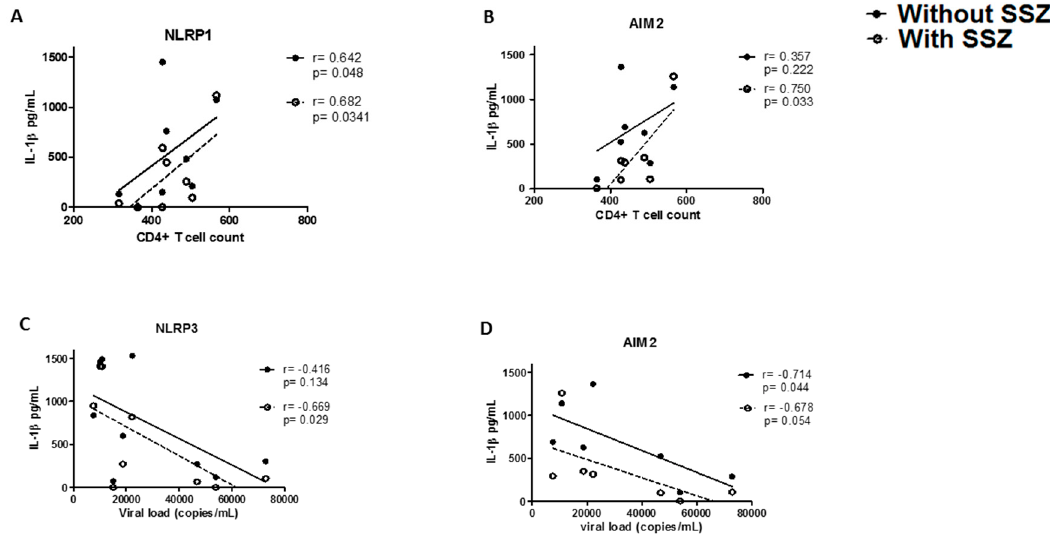
Figure 5. Correlation between IL-1 β release in response to inflammasome agonists and sulfasalazine (SSZ) in term of the CD4+ T cells count or viral load. The effect of SSZ on IL-1 β release through inflammasomes was determined in people living with HIV, on the basis of the CD4 + T cell count ( A , B ) and viral load ( C , D ). The correlations were estimated using Spearman’s rank correlation coefficients. The r and p values of the correlations are indicated at the top of each figure; a p -value of < 0.05 was considered statistically significant. Black spots represent PBMCs treated only with inflammasome agonists. White spots represent PBMCs treated with inflammasome agonists and SSZ. Dashed-line indicates the correlation trend in the presence of SSZ. Continuous line indicates the correlation trend in the absence of SSZ.